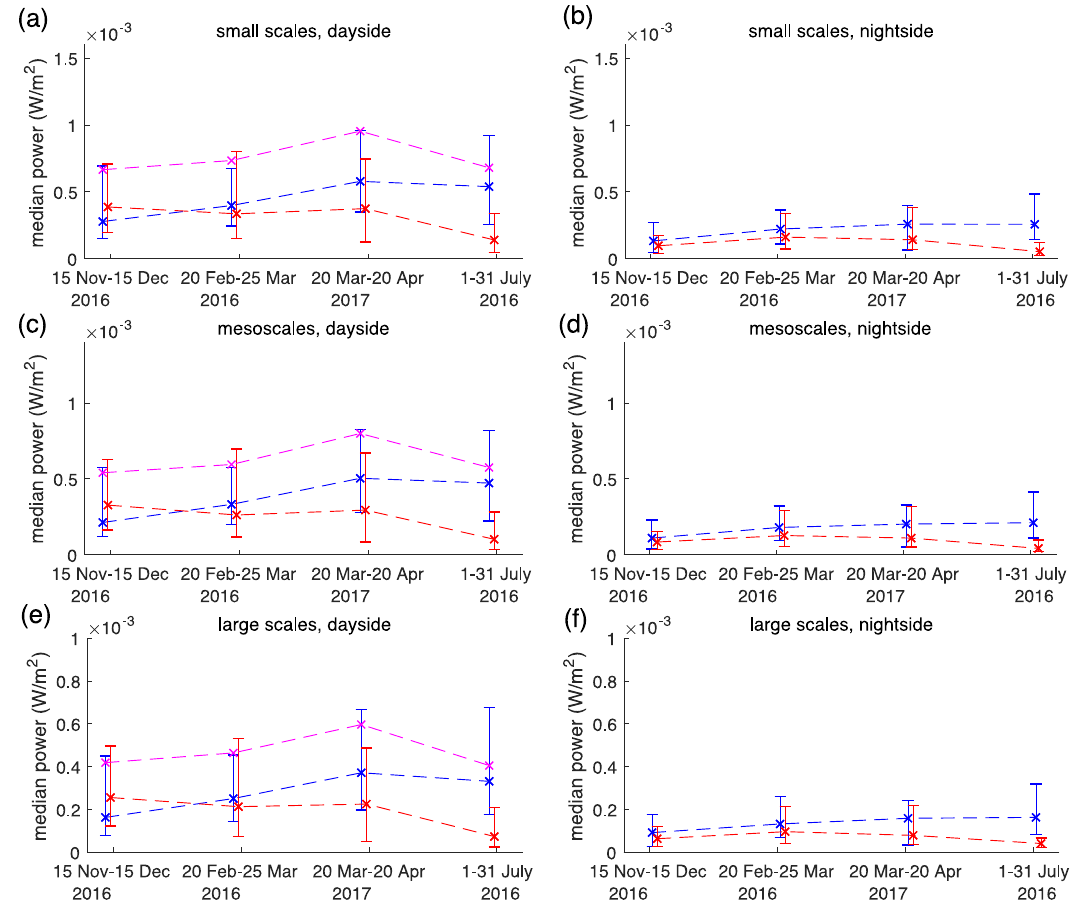
Fig. 2 Median values of electromagnetic power at small, medium and large scales for near-solstice and near-equinox periods in the noon – midnight local time meridian. Electromagnetic energy in northern, southern and combined (northern plus southern) dayside (blue, red, pink, respectively; a , c , e ) and in the northern and southern hemisphere on the nightside (blue, red, respectively; b , d , f ) passes are shown at three spatial scales. Band-pass fi ltering was done using the Savitzky-Golay fi lter, with small scales ( a and b ) derived using time domain fi lters characteristic of 75 km along track scales; medium scales ( c and d ) characteristic of 200 km along track scales; and large scales ( e and f ) characteristic of 350 km along track scales. Dashed lines connect the median values (marked with crosses), while the error bars show the lower and upper quartiles in terms of magnitude. The positions of the medians and error bars for different MLT and hemisphere sectors during the same time periods have been slightly shifted on the x -axis for visual effect and to enable the reader to better differentiate between the error bars. Note as explained in “ Methods ” that all electromagnetic power values are derived by integrating in time along the spacecraft world-line during an event, and dividing by the duration of the